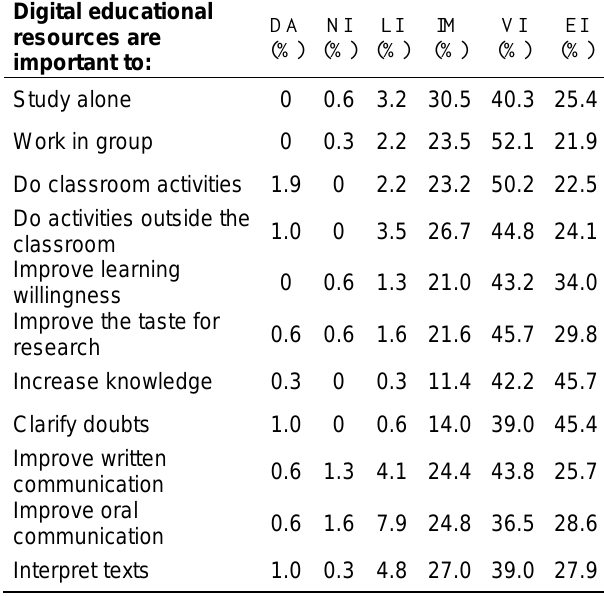
Table 2. Digital educational resources in